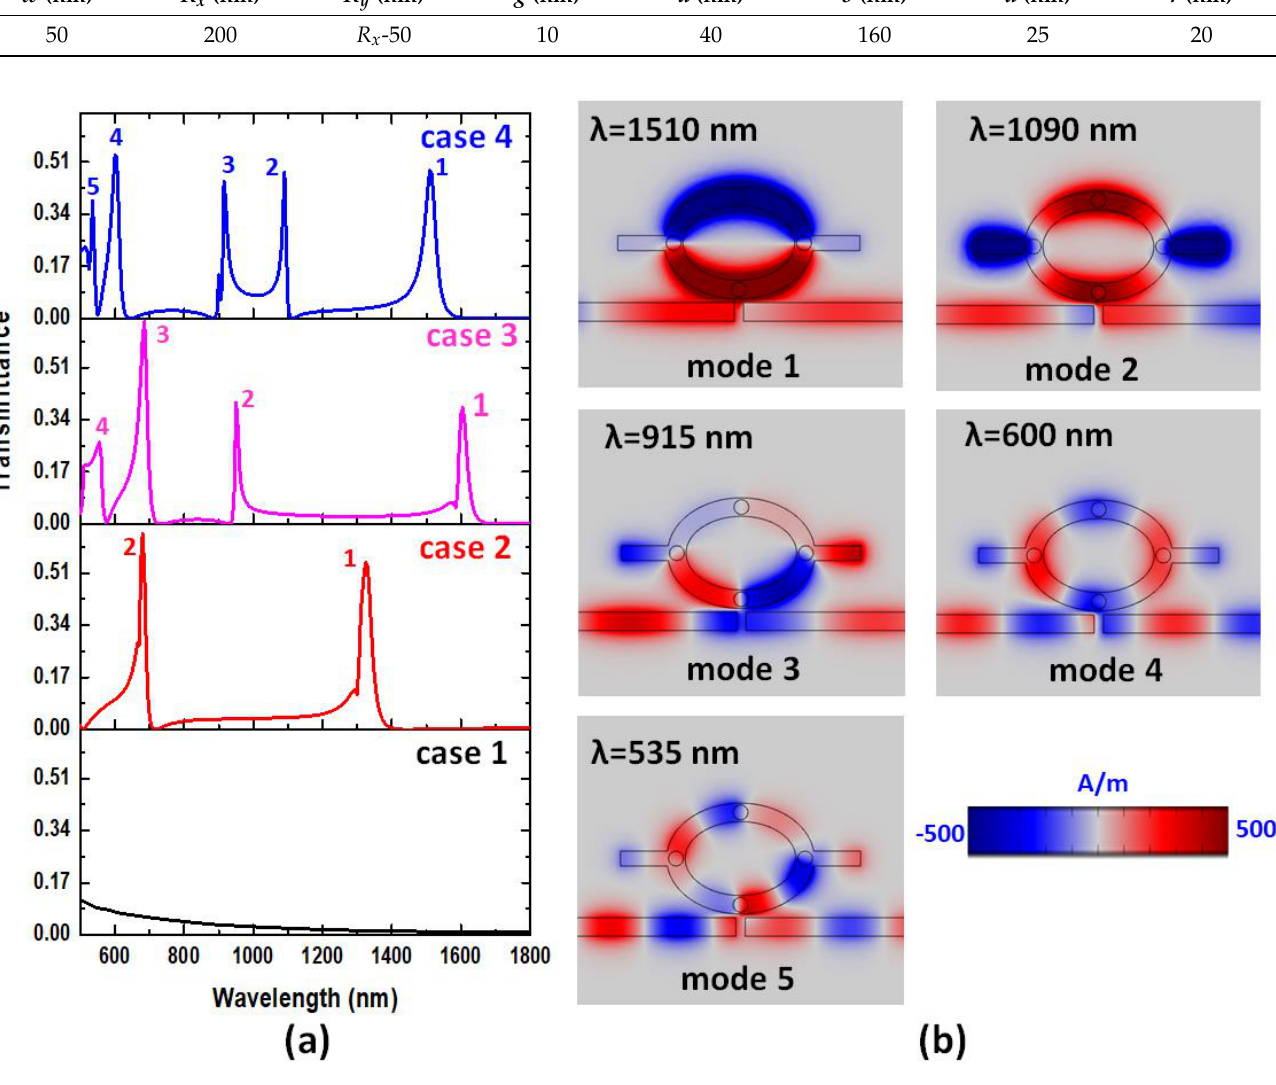
Figure 2. ( a ) Transmittance spectrum of the designed plasmonic sensors (i.e., cases 1 – 4) in the wave- length range of 500 – 1800 nm. ( b ) Truncate views of magnetic field (H-field) distributions at corre- sponding λ res of mode 1 to 5 of case 4 structure. Numbers mark the valid resonance modes.